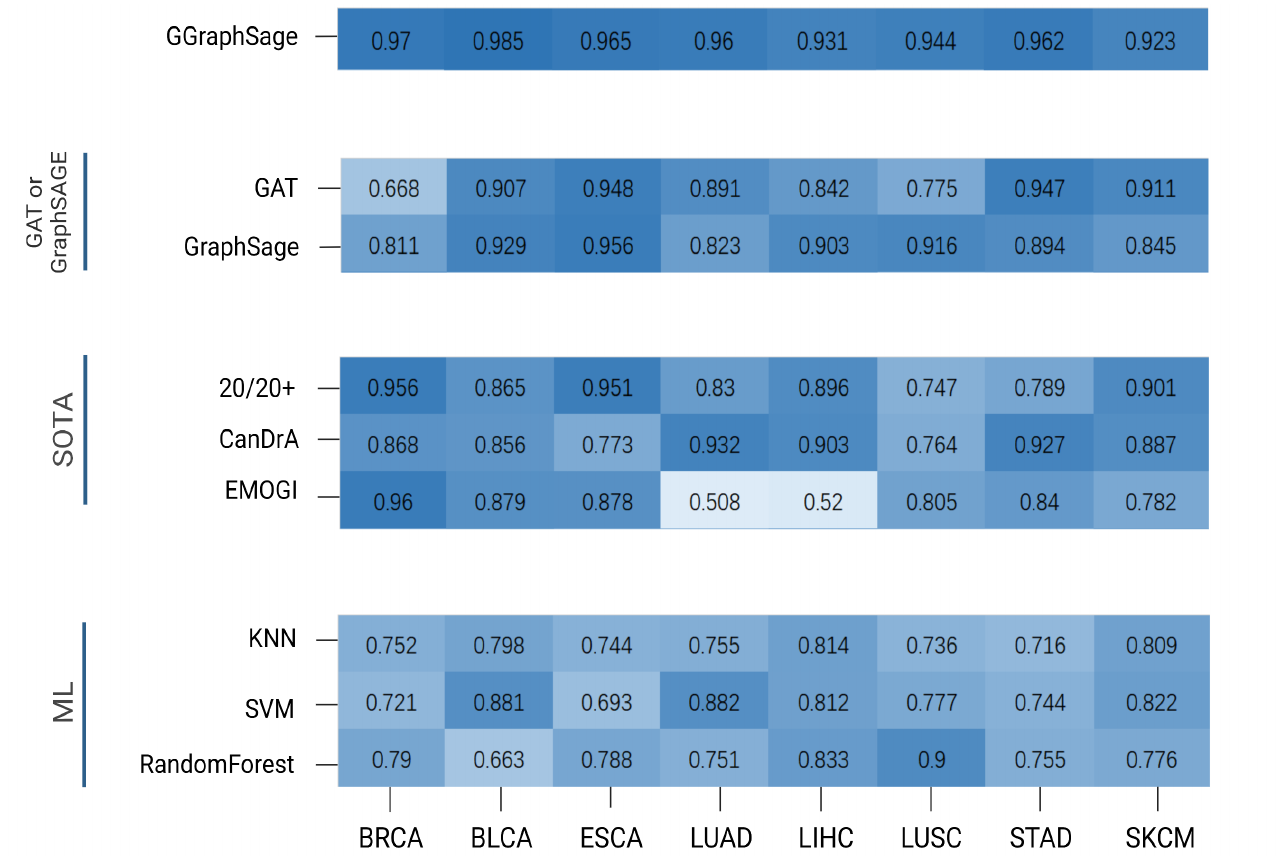
Figure 5. Performance comparison of GGraphSAGE with other methods. The heatmap reveals the performance (AP) comparison of different methods for each tumor type, with darker colors indicating higher AP values. These methods were divided into 4 categories: GGraphSAGE: the combination of GAT and GraphSAGE; GAT or GraphSAGE: GAT or GraphSAGE model only; SOTA methods: 20/20+, CanDrA, and EMOGI; ML (machine learning): KNN, SVM, and random forest. As can be seen from the figure, GGraphSAGE has a high AP value on each tumor type, and its performance is better than other